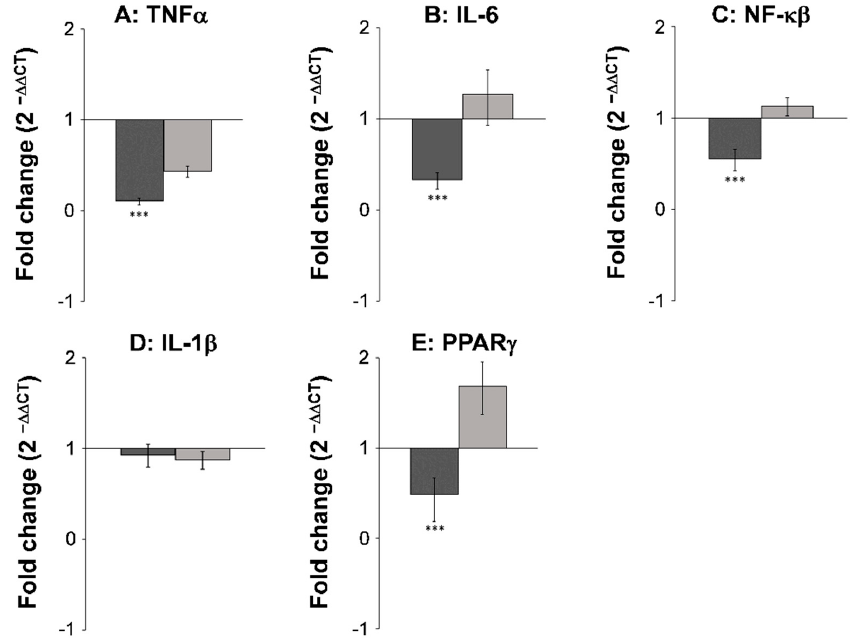
Figure 4. FaOH and FaDOH downregulates expression of TNF α , IL-6, NF- κβ and PPAR γ 2 in neoplastic tissue in colorectal cancer primed rats. Up- and downregulation of TNF α ( A ), IL-6 ( B ), NF- κβ ( C ), IL-1 β ( D ) and PPAR γ 2 ( E ) in neoplastic and healthy tissue in rats after treatment with FaOH and FaDOH. The up- and downregulation of the above-mentioned biomarkers was calculated using the CT method. Dark grey bars represent neoplastic tissue and light grey bars represent healthy tissue. All values represent the mean ± SD. *** p < 0.001.